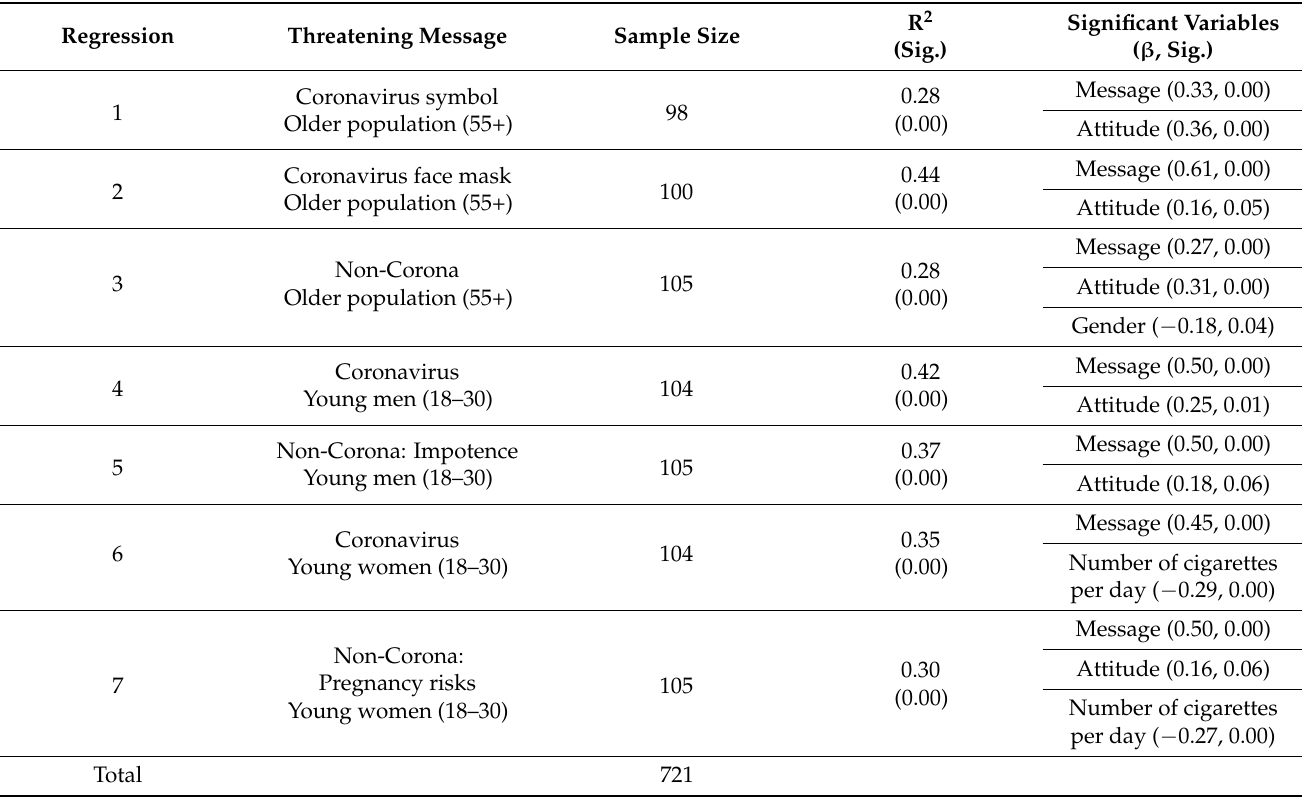
Table 2. The main study regressions’